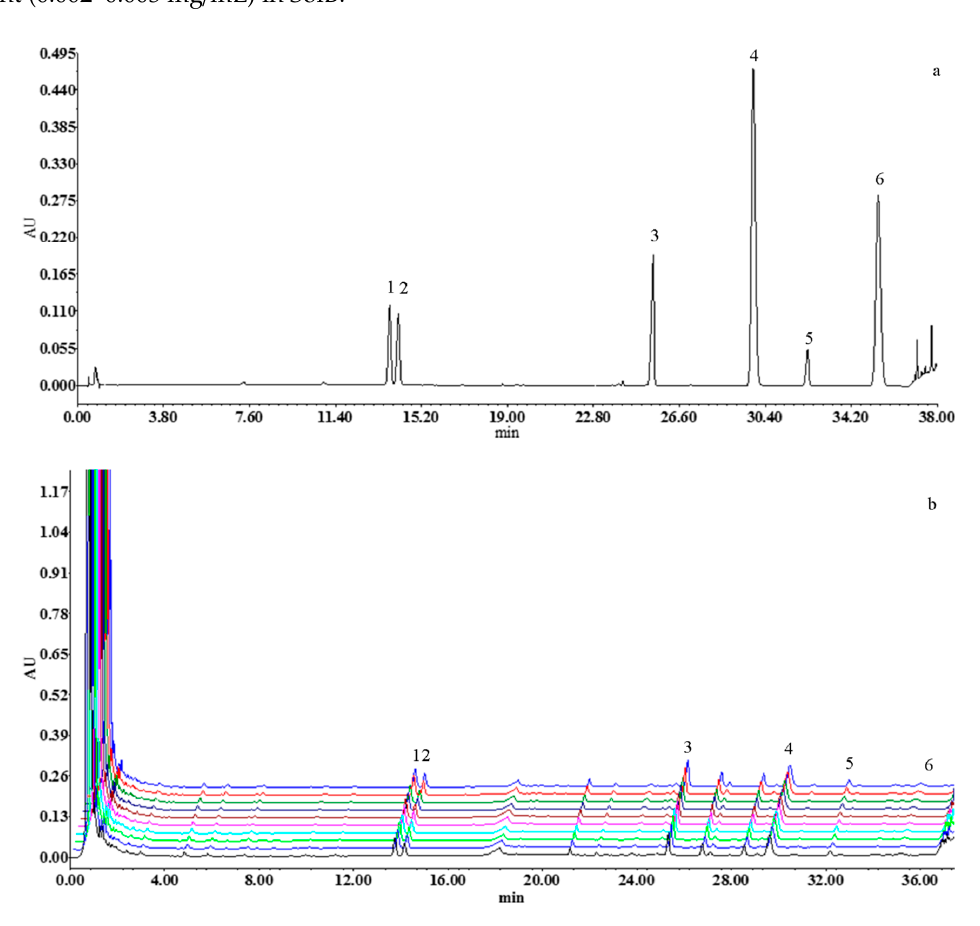
Figure 7. Ultra-performance liquid chromatography diode array detection (UPLC-DAD) chromatograms of ( a ) the mixed reference solution, ( b ) the fingerprint of ten batches of SMI (203 nm, 1: Rg 1 , 2: Re, 3: Rb 1 , 4: Rd, 5: SolA, 6: SolB).